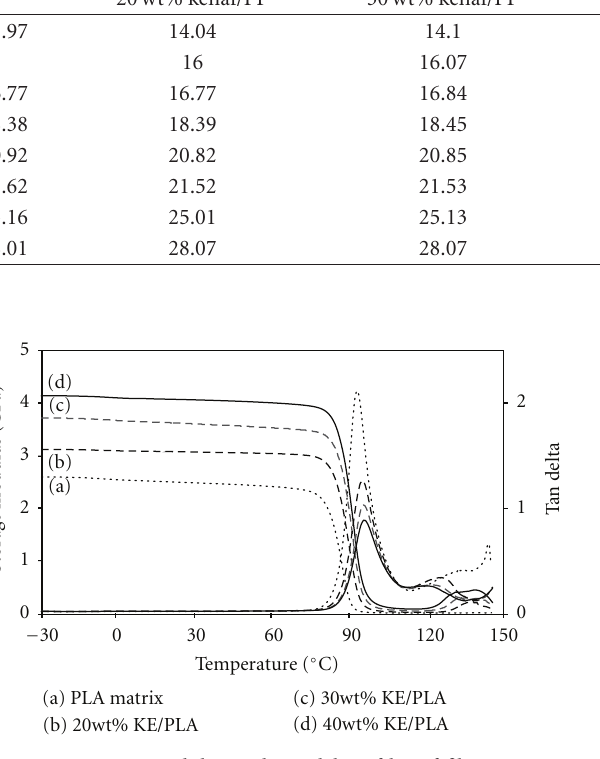
Figure 3: Storage modulus and tan delta of kenaf fiber/PLA as a function of kenaf content and temperature.